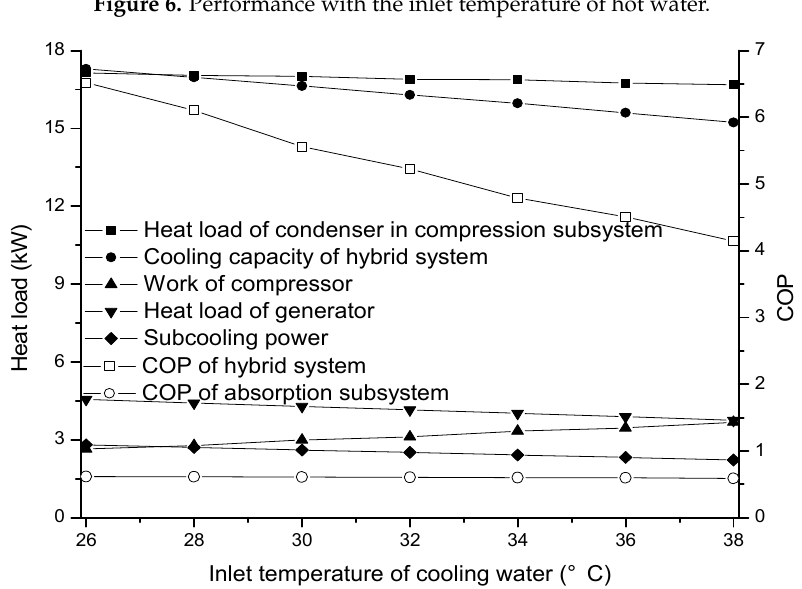
Figure 6. Performance with the inlet temperature of hot water.